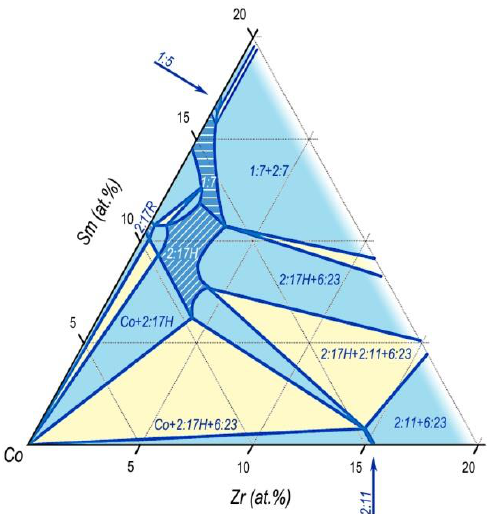
Figure 8. Isothermal section of Co corner of the ternary Co–Sm–Zr phase diagram at 1200 °С (compilation of data of Nishio et al. [25]).